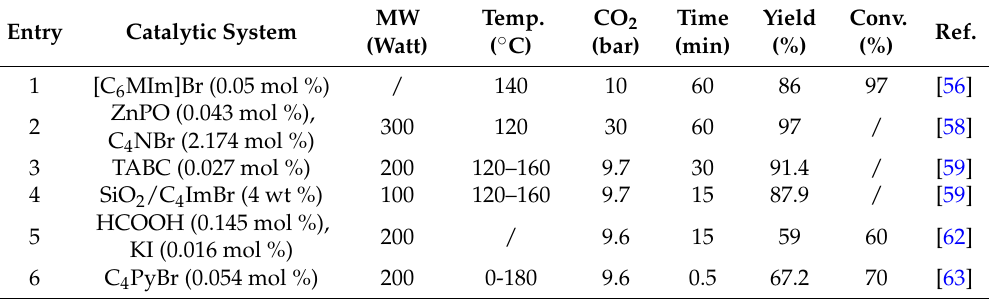
Table 1. MW-assisted synthesis of cyclic